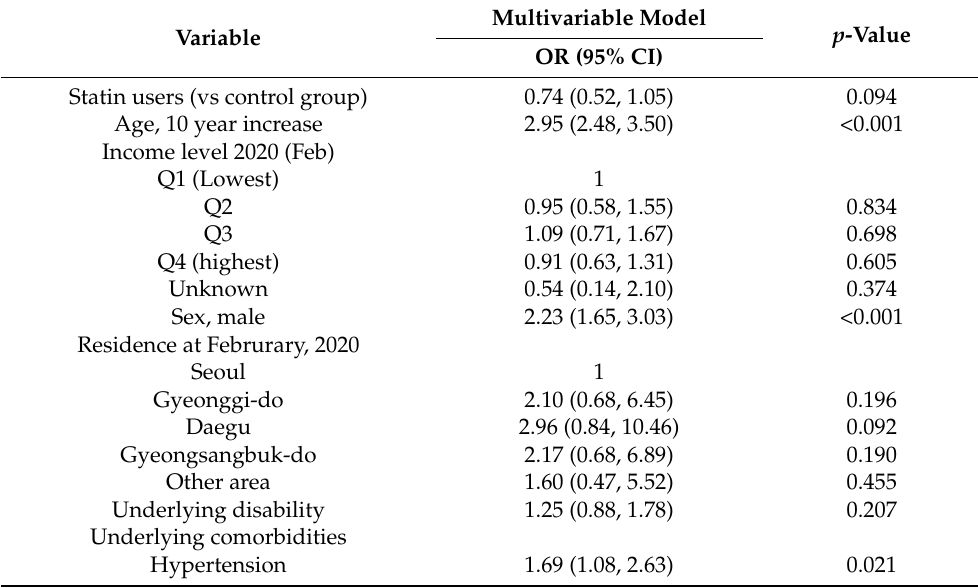
Table 4. Multivariable logistic regression model for hospital mortality in COVID-19 patients ( n = 7780, death = 251,